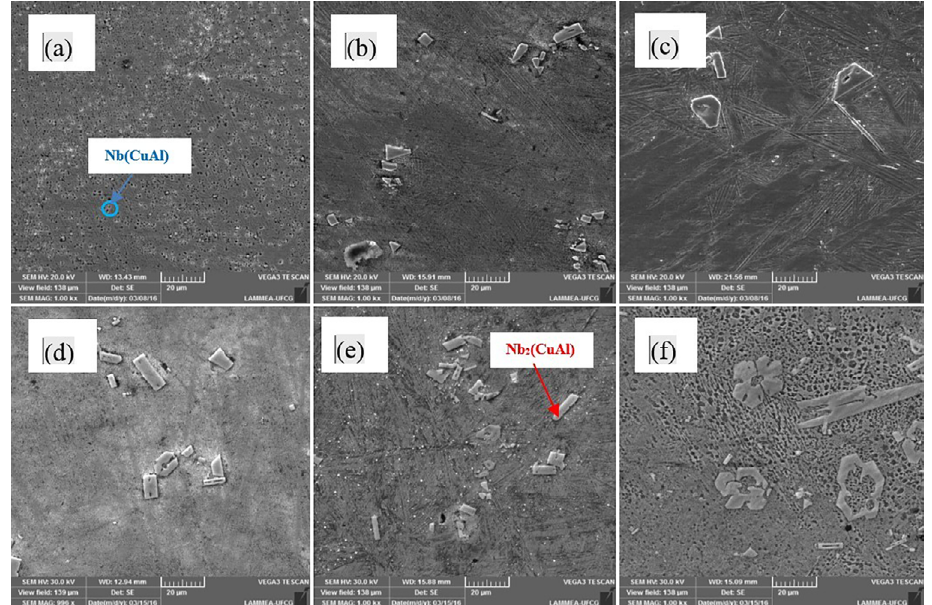
Figure 5. SEM images revealing precipitate particles with 1000x magnification. Numbers indicate the Nb content in wt%.